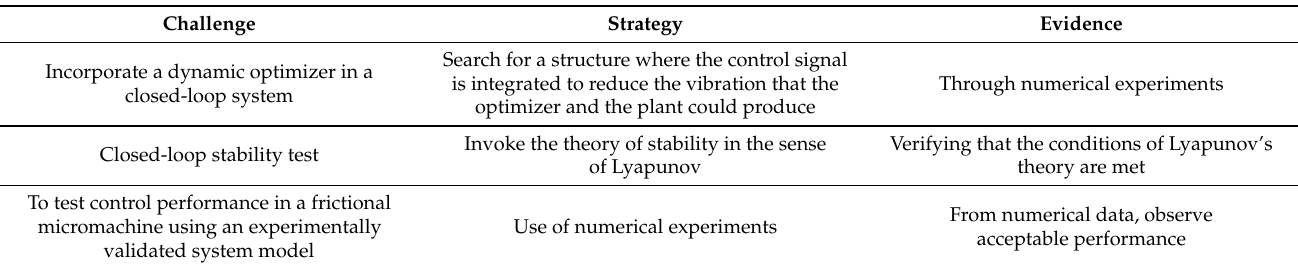
Table 1. Main challenges for control